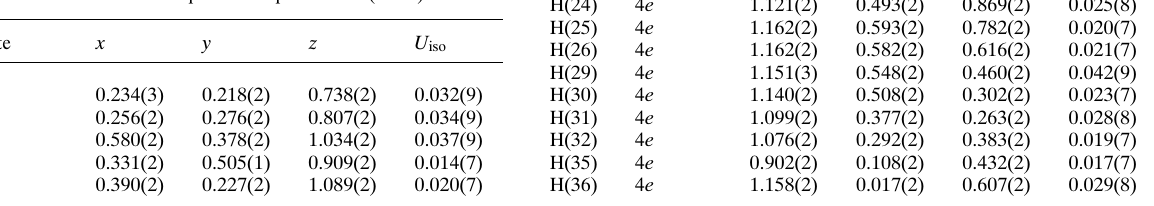
Table 2. Atomic coordinates and displacement parameters (in Å 2 ) .